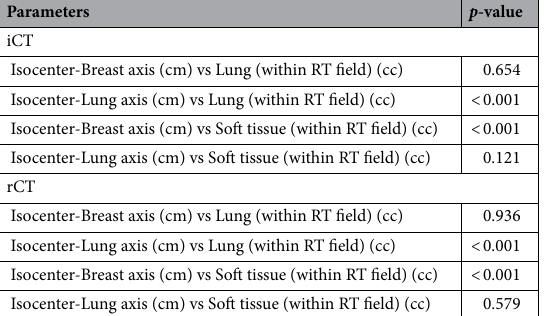
Table 4. Representative results of correlation analyses between clinical parameters.